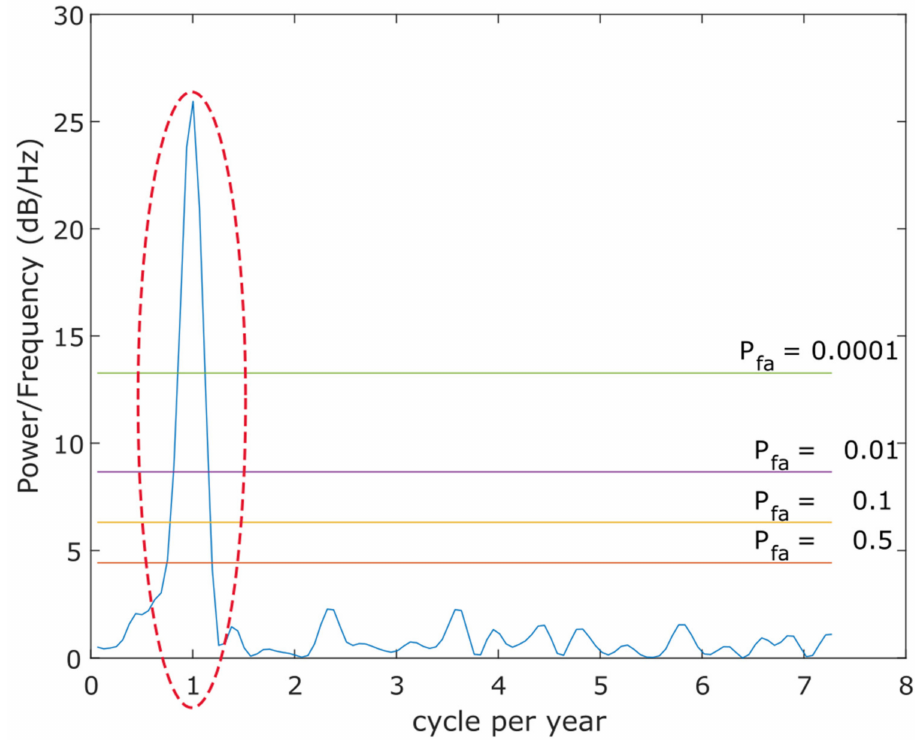
Figure 3. Example of periodogram for point no. 102 in the Tvrdonice UGS area. The period of 365 days, i.e., one cycle per year, which is significantly represented in the data, is marked by a red oval. Significance was determined using significance levels, where the coe ffi cient (s) P fa (0.5; 0.1; 0.01; 0.0001) correspond to significance levels of 50%, 10%, 1% and